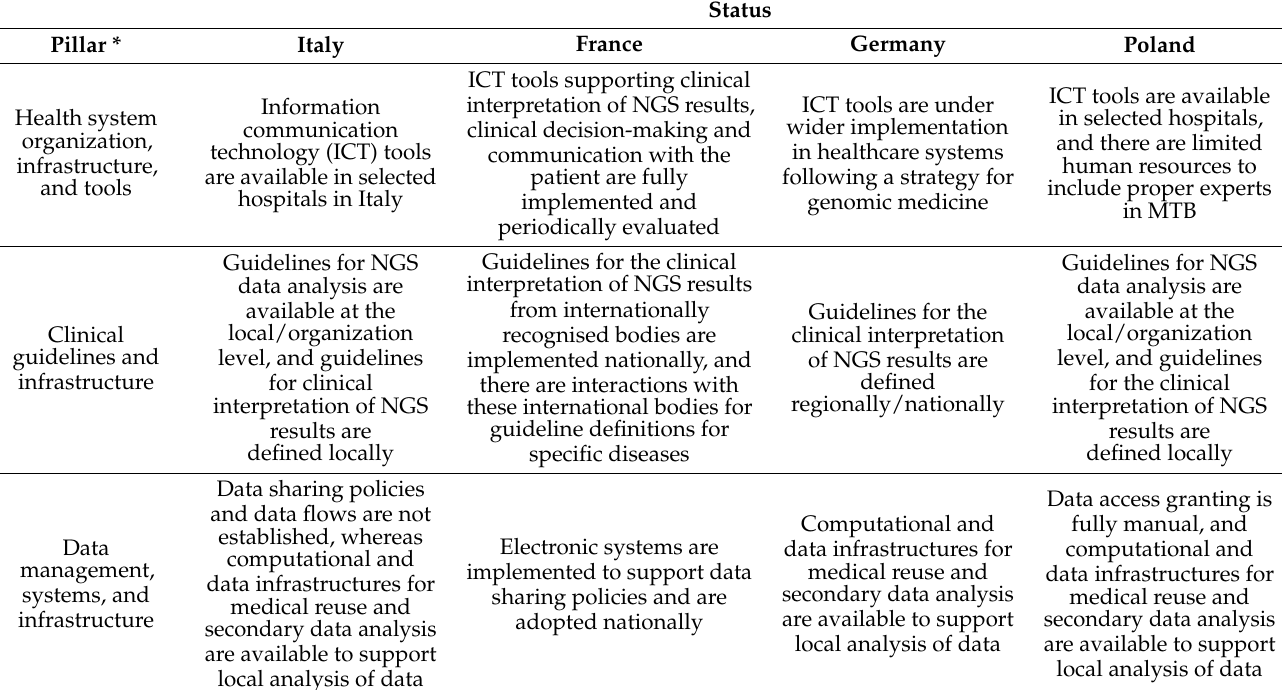
Table A4. Status of NGS maturity levels for a few countries from Europe.